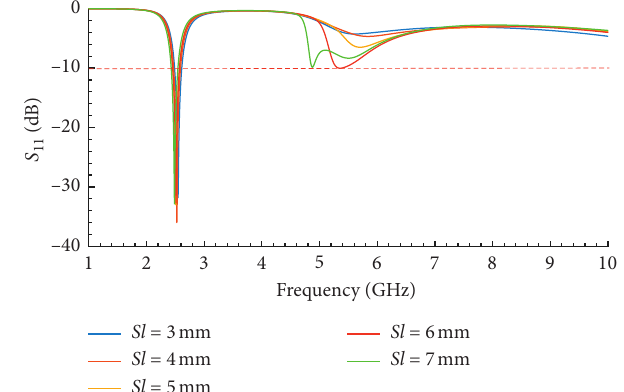
Figure 24: S 11 changes due to